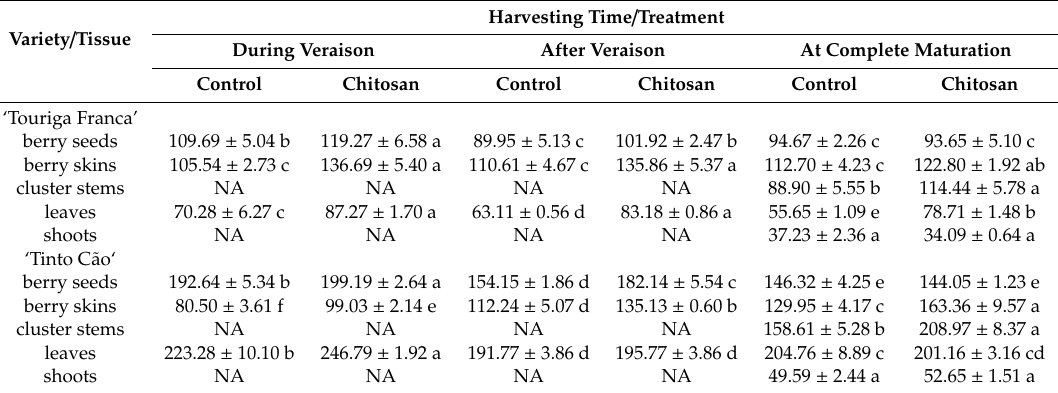
Table 2. The total phenolic content.